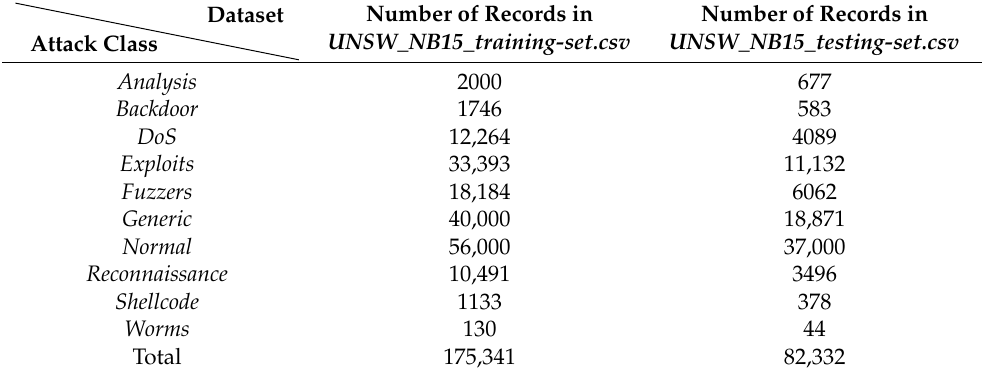
Table 3. The number of labeled records in UNSW_NB15 training and testing datasets.